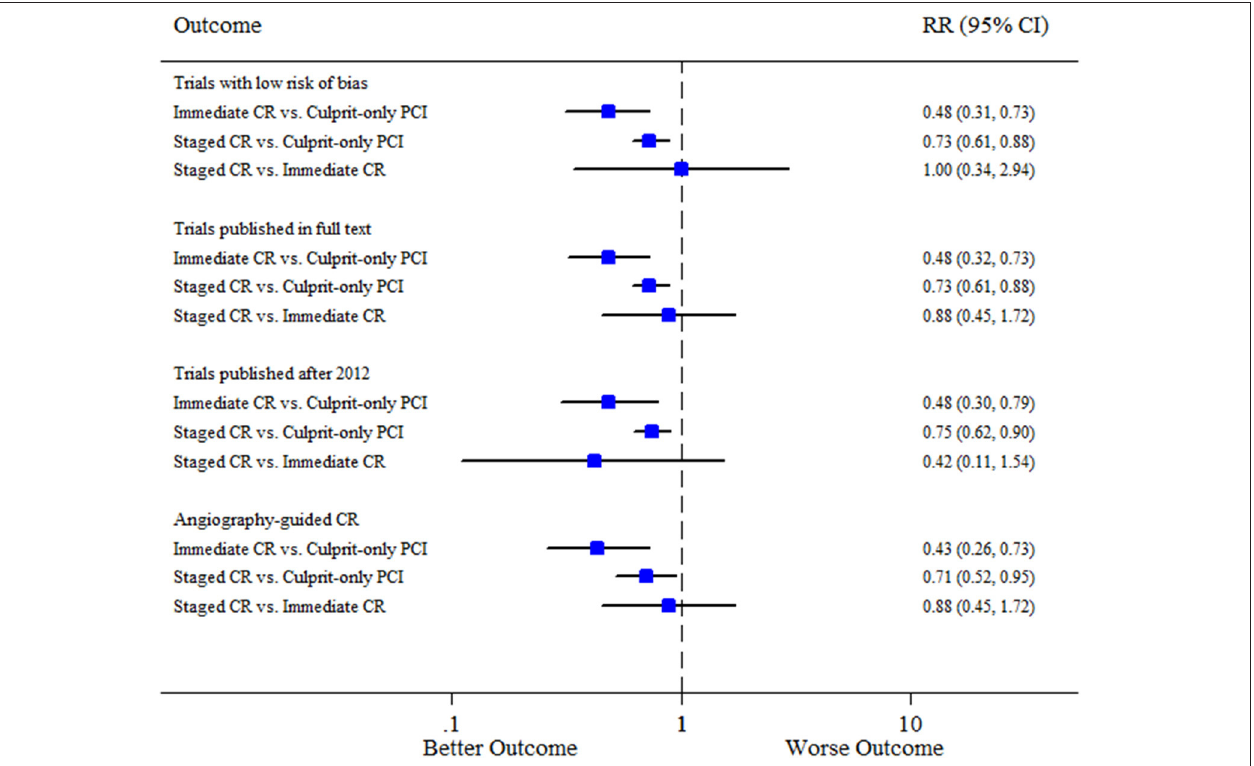
FIGURE 3 | Sensitivity analysis. CI, confidence interval; CR, complete revascularization; PCI, percutaneous coronary intervention; RR, relative